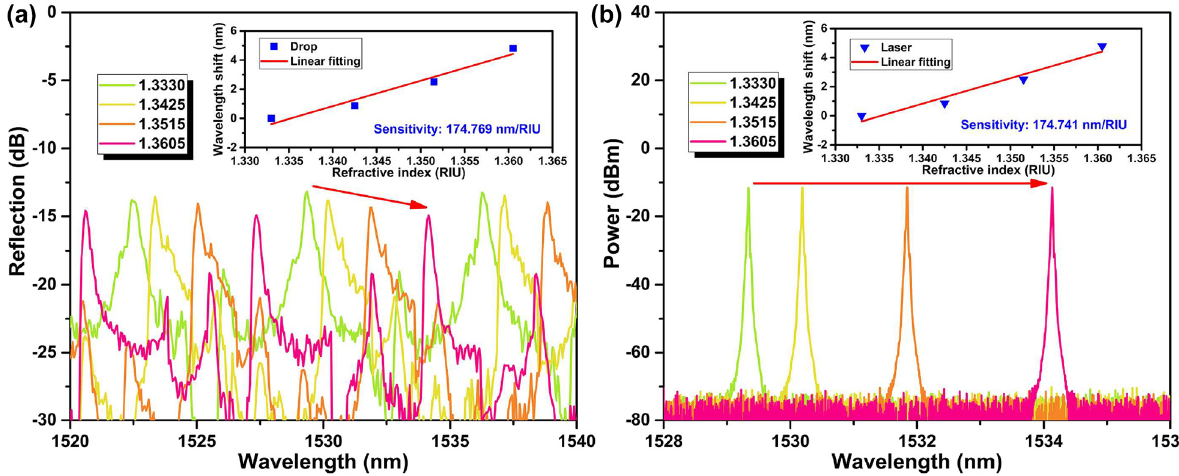
Figure 8: Spectral evolutions of (a) the drop port reflection and (b) the output sensing laser at different refractive index. Insets: refractive index sensitivities of peak wavelengths.